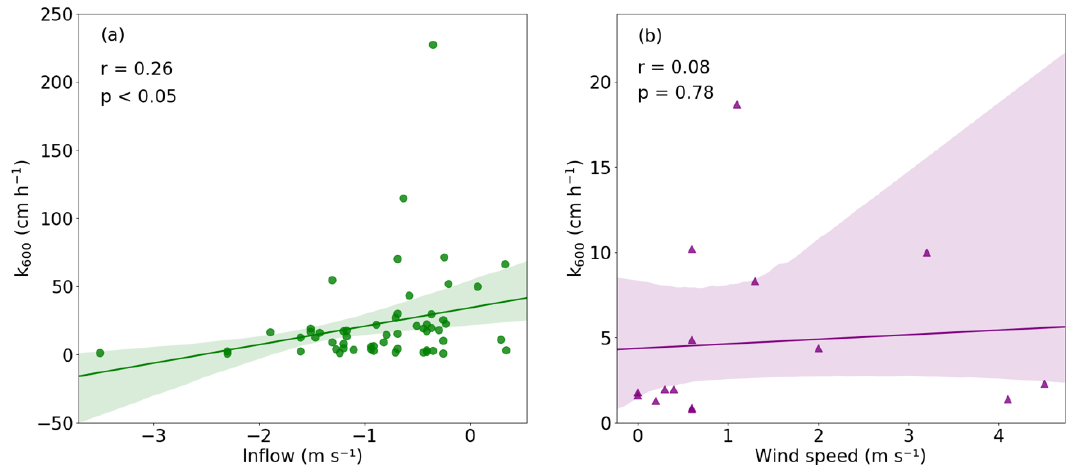
Figure 7. Scatterplots showing the relationship between k 600 and flow velocity (log-transformation) at the rivers ( a ) and k 600 and wind speed at the reservoirs ( b ) after an outlier was omitted in the KRB. The shaded region represents the 95% confidence interval for the regression estimate using bootstrapping technique.